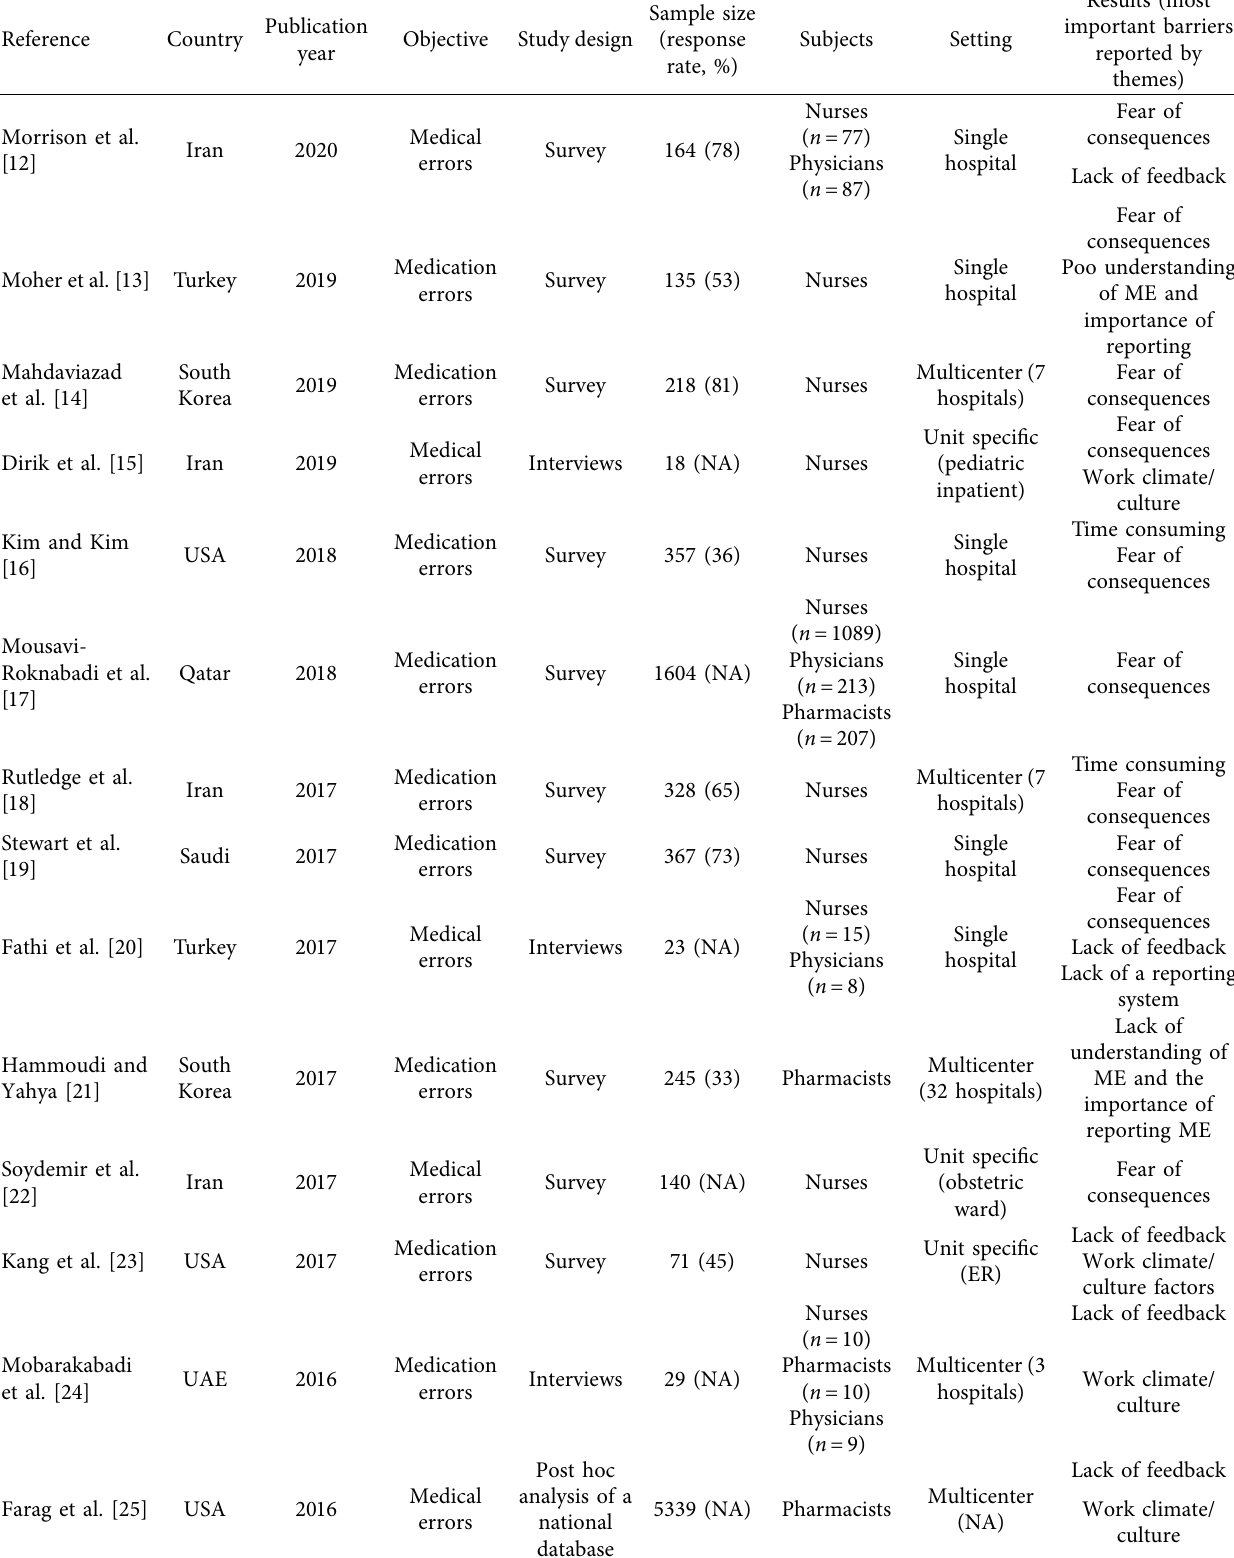
Table 1: Summary of the selected